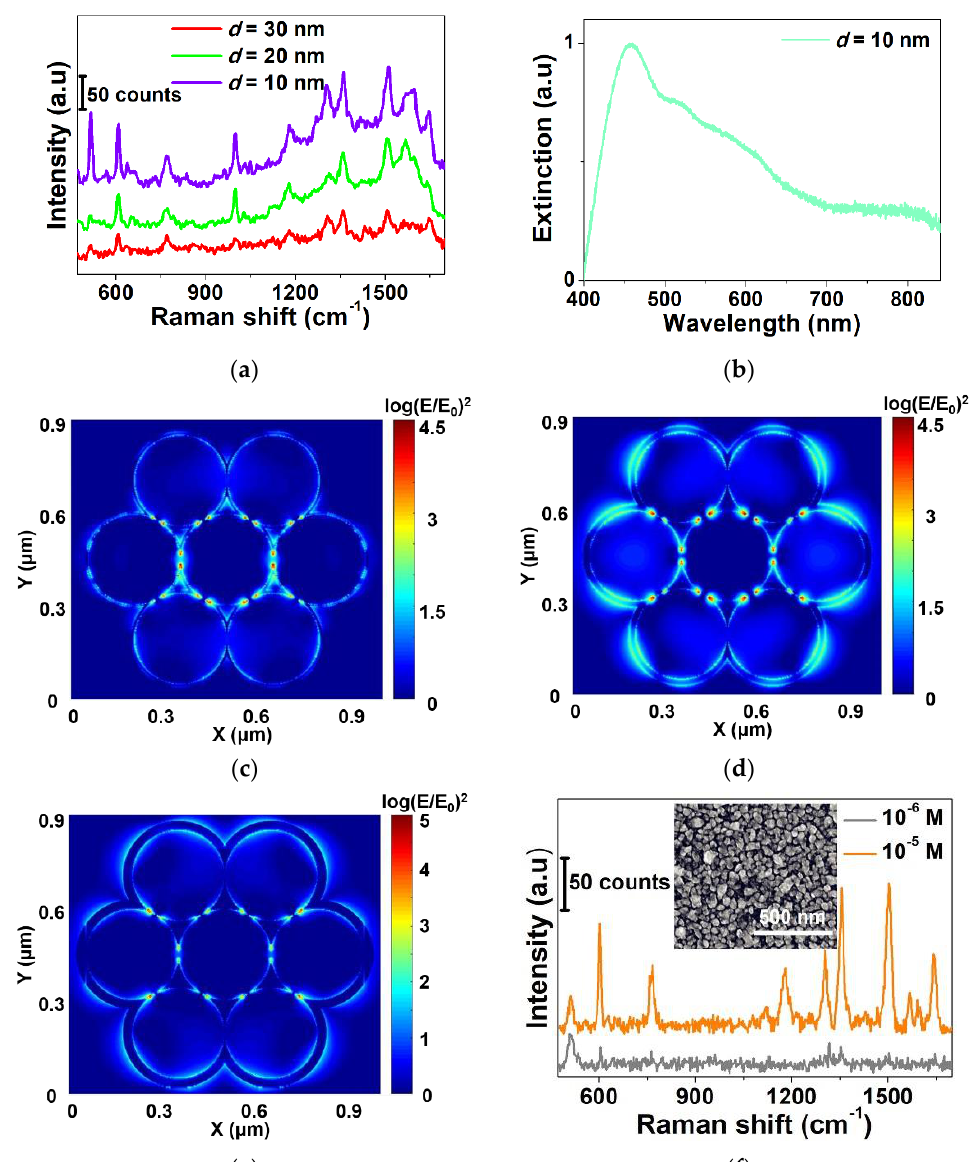
Figure 2. ( a ) Raman spectra of R6G (10 − 9 M) deposited onto the SERS substrates with a Ag film thickness of d = 10 nm, 20 nm, and 30 nm; ( b ) Extinction spectrum of the SERS substrate with a Ag film thickness of d = 10 nm; ( c – e ) Electric field intensity distributions near the surface of the SERS substrates with an Ag film thickness of 10 nm, 20 nm, and 30 nm, respectively; ( f ) Raman spectra of R6G with concentrations of 10 −5 M and 10 −6 M deposited onto the Ag-film coated silicon wafer with a Ag film thickness of d = 10 nm. Inset is the SEM image of the Ag-film coated silicon wafer with an Ag film thickness of 10 nm.